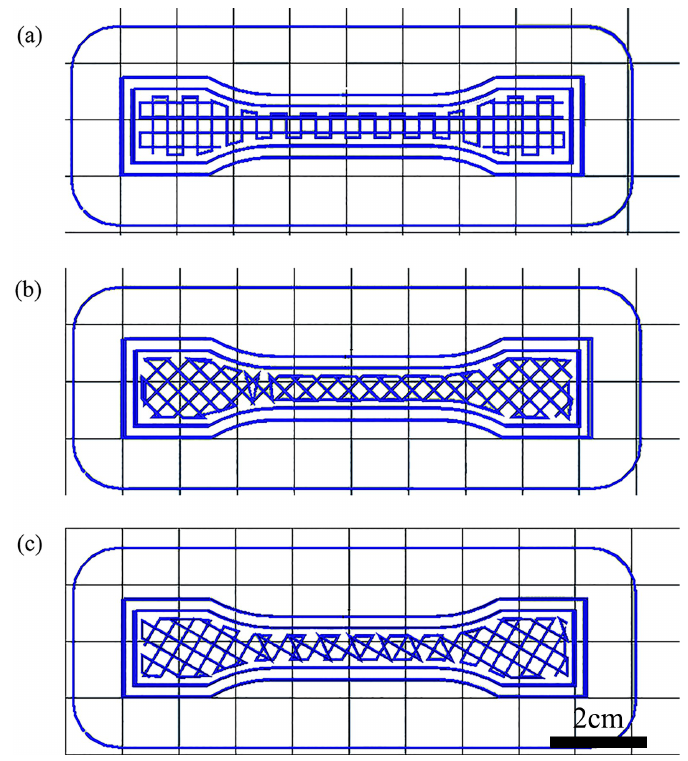
Figure 6. Types of raster angle used in 3D printing of the tensile test specimens: ( a ) 0°/90°; ( b ) ±45°; ( c ) 60°/ − 30°.